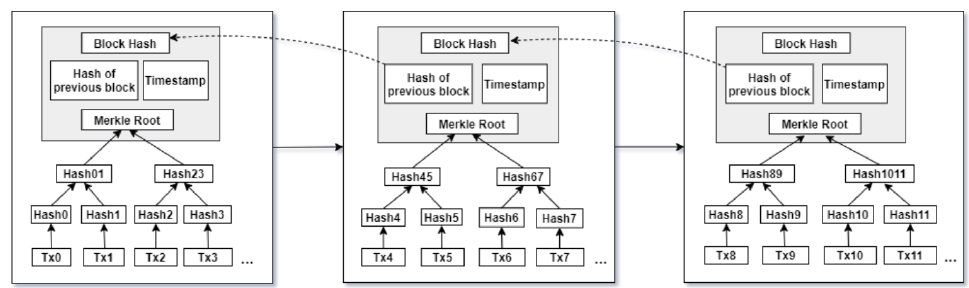
Figure 1. Blockchain structure, adapted from